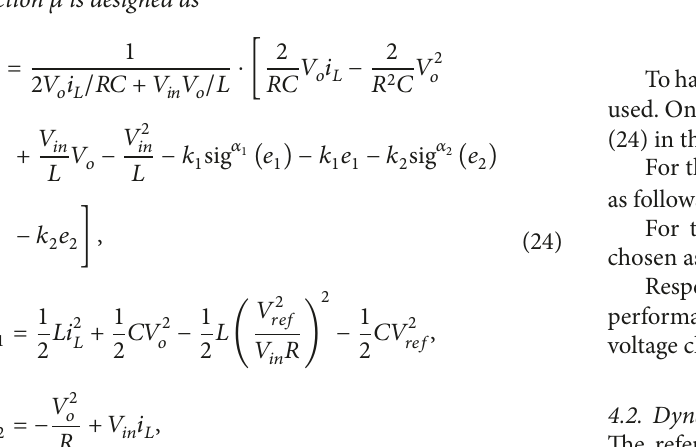
Figure 2: The response curves for output voltage under two control algorithms: finite-time control (FC) and PI